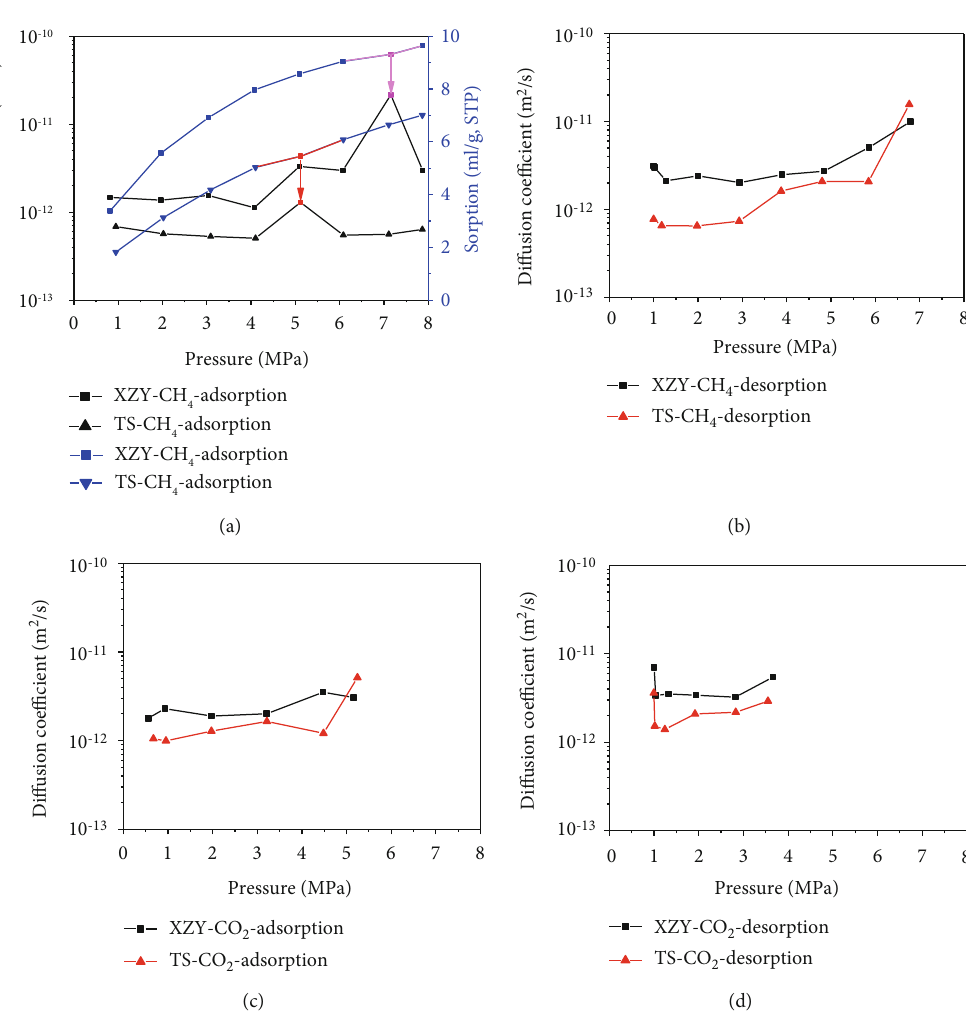
Figure 5: Gas di ff usion coe ffi cient variation with gas pressure.